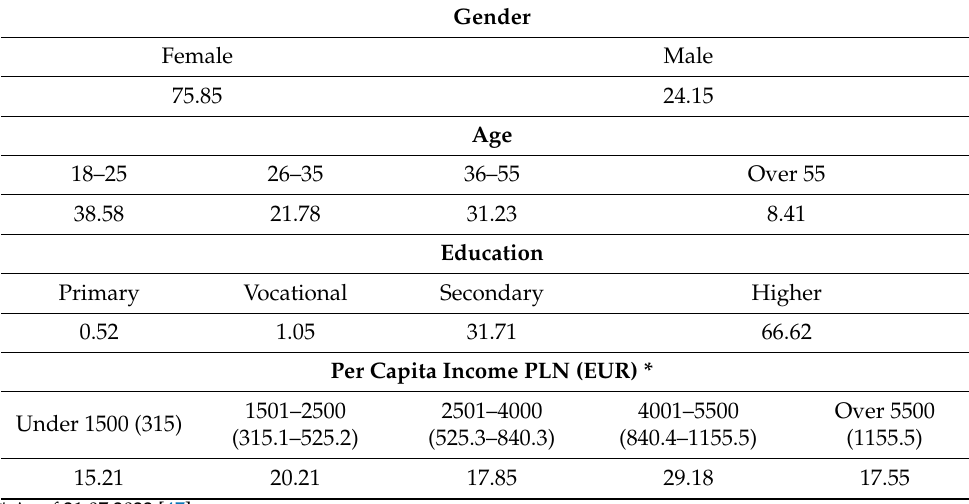
Table 1. Sample characteristics